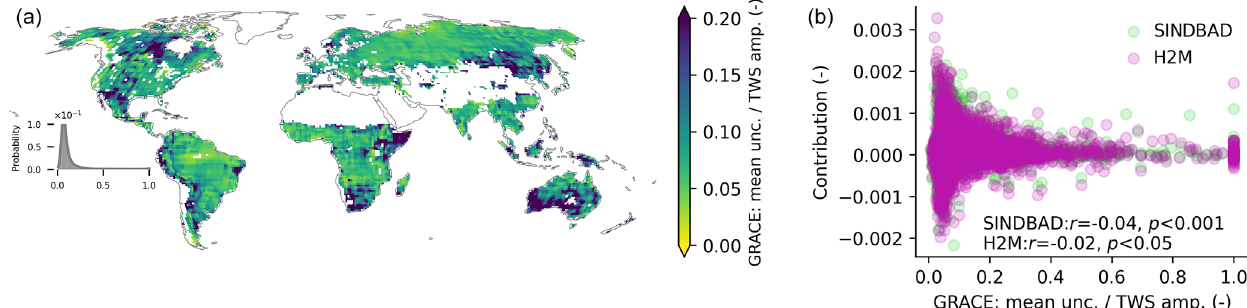
Figure B5. (a) Spatial distribution of the relative uncertainty in GRACE terrestrial water storage (TWS) observations. The relative uncertainty in each pixel is calculated as the mean uncertainty divided by the amplitude of TWS. (b) Scatterplots comparing the relative uncertainty in GRACE TWS ( x axis) versus pixel-wise contributions to the global TWS IAV modeling error ( y axis). Shown below as text is the Pearson correlation coefficient with the p value of each model.